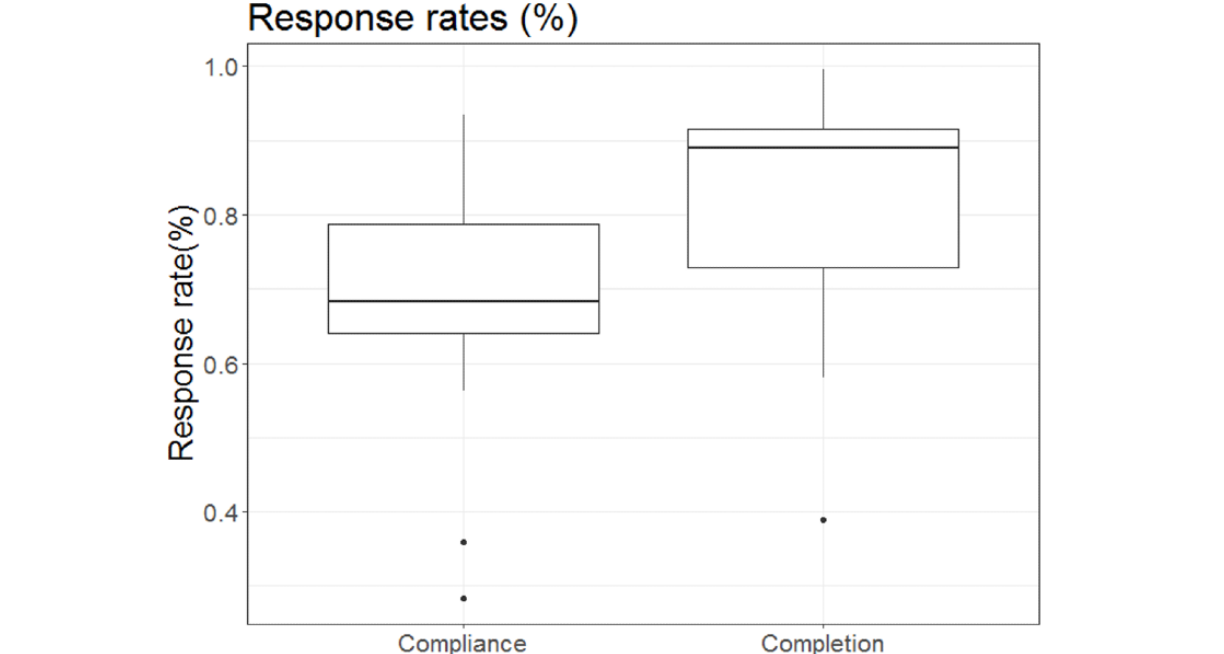
Figure 3. μEMA compliance and completion